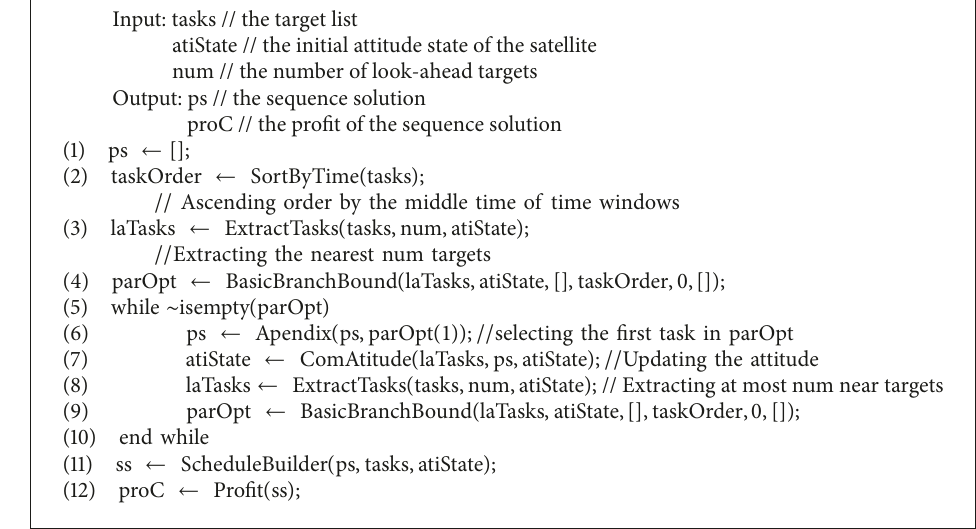
Algorithm 3: Look-ahead construction method.